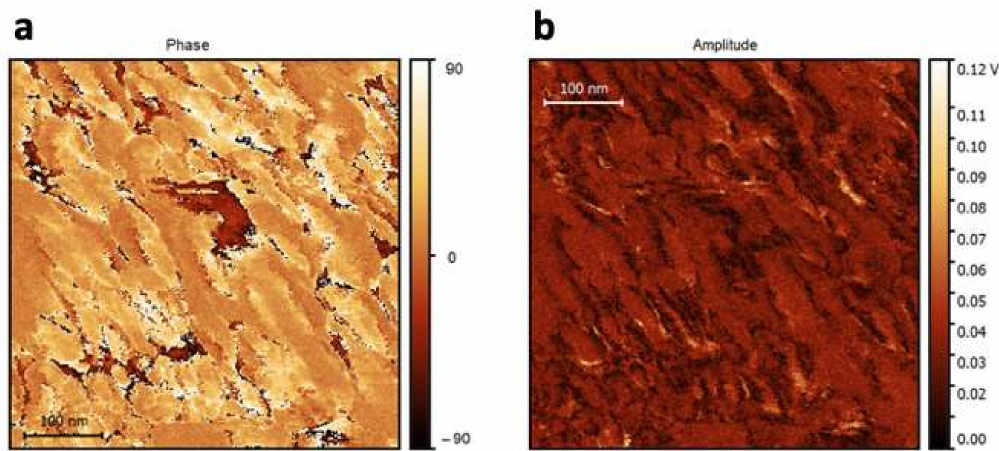
Figure 9. ( a ) The PFM phase and ( b ) the PFM amplitude of the